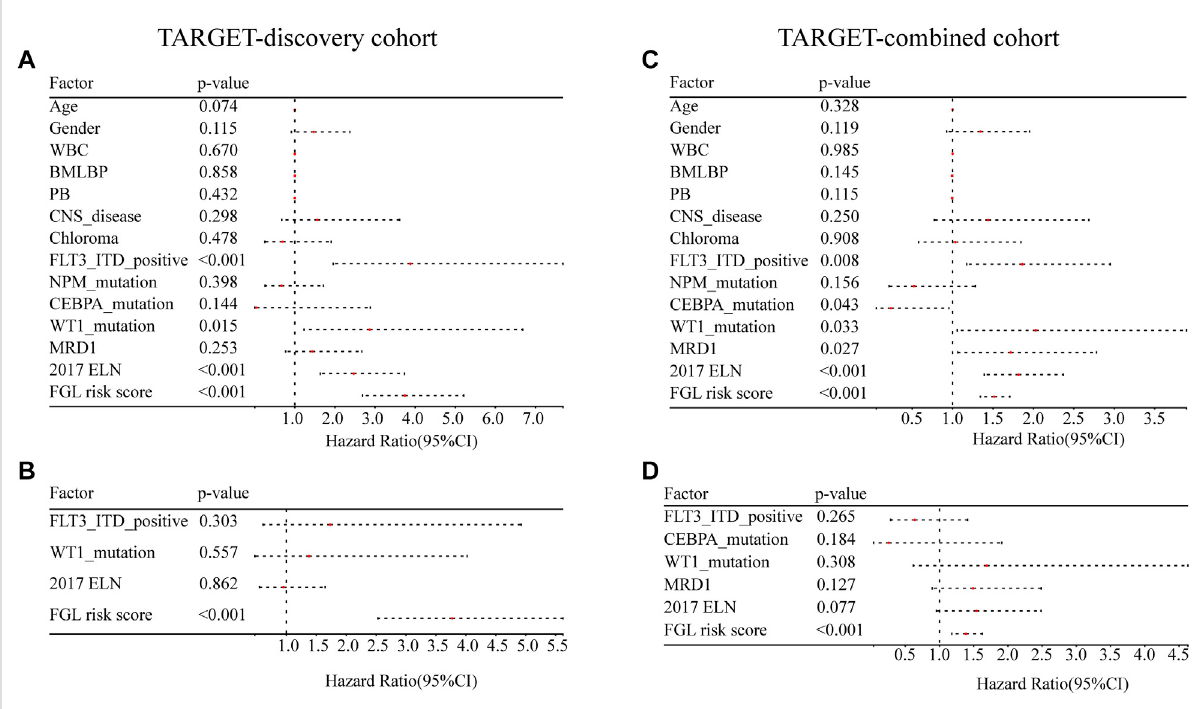
FIGURE 4 Evaluation of the FGL model in the TARGET-discovery and -combined cohort. Independent prognostic effects of the risk score model were assessed by (A,C) univariate Cox regression analysis and (B,D) multivariate Cox regression analysis.